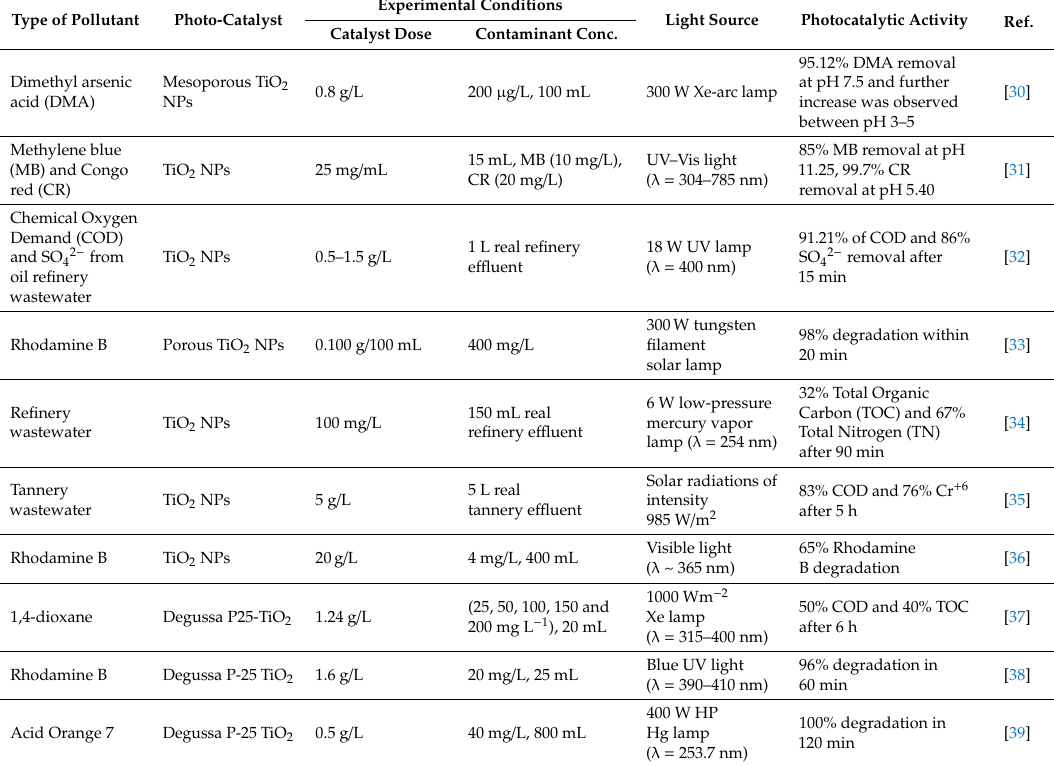
Table 1. TiO 2 NPs applications for photocatalytic degradation of industrial wastewater